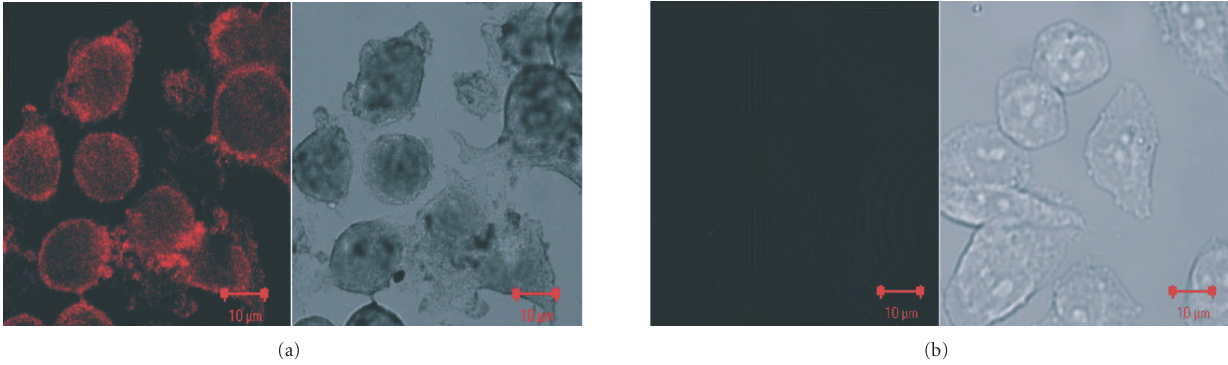
Figure 7: Confocal reflectance images (left) and bright field images (right) of (a) SKBR3 cells incubated with silver-stained HER81/gold sphere conjugates, (b) CHO cells under the same conditions. Care was taken to maintain the same acquisition parameters in both cases. The silver-stained bioconjugates are detected at the cell membranes of SKBR3 cells where HER2 is localized. This indicates successful conjugation and retention of functionality of the antibody after conjugation. No such accumulation of HER81/gold sphere conjugates is demonstrated in HER2 negative CHO